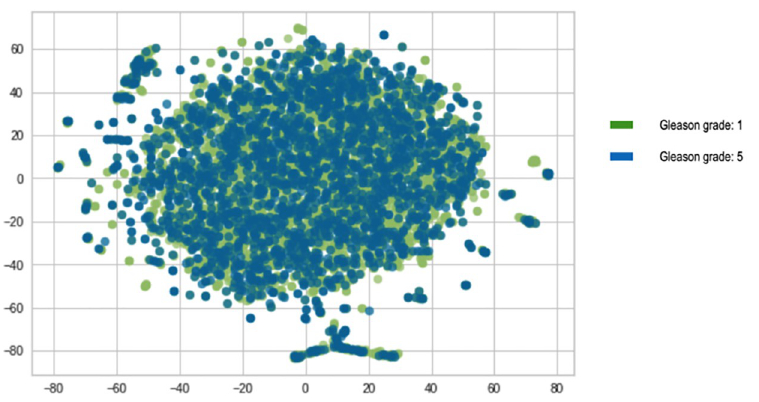
Fig 5. Visualisation of TF-IDF kmers for BRCA 1